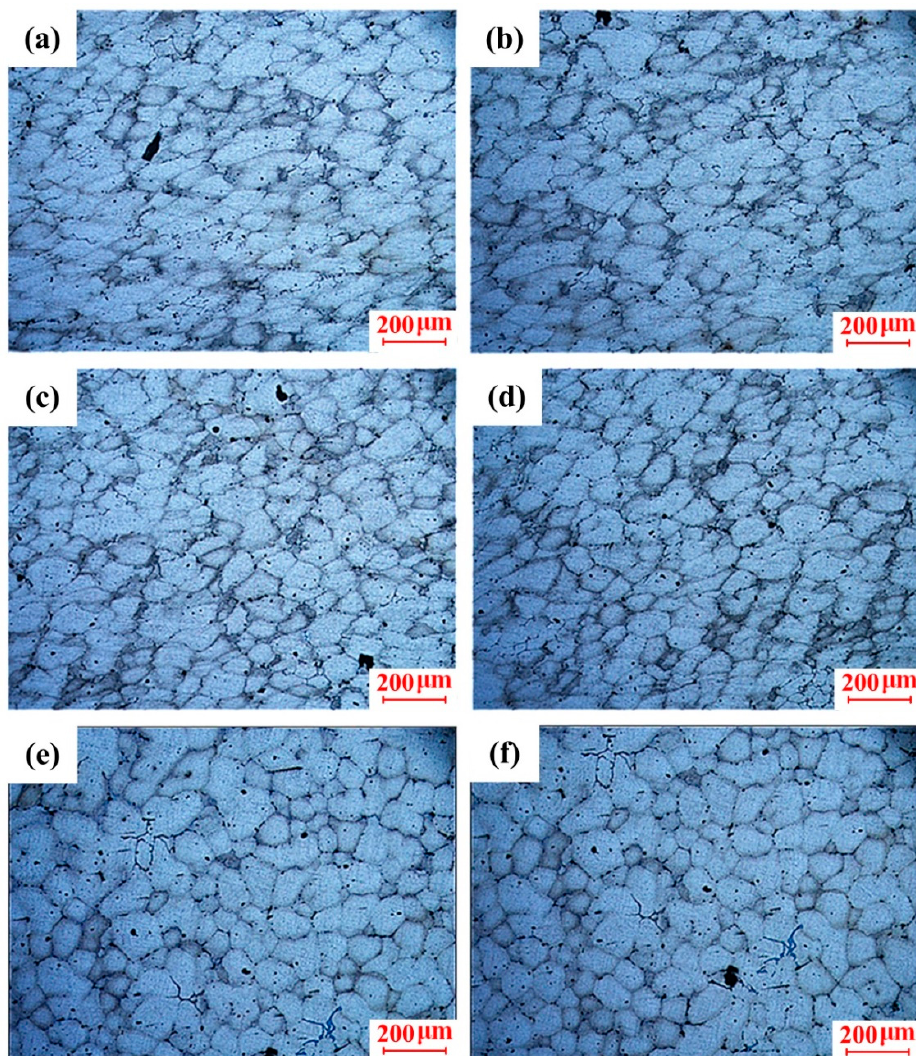
Figure 13. Microstructures at different positions of the scroll: ( a ) Position A in the top region, ( b ) Position B in the top region, ( c ) Position C in the central region, ( d ) Position D in the central region, ( e ) Position E in the bottom region, and ( f ) Position F in the bottom region.